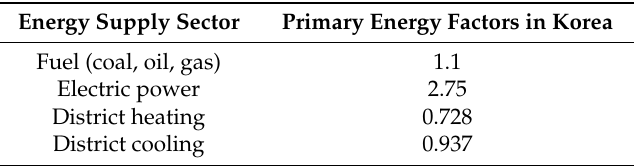
Table 3. Primary energy factors in Korea